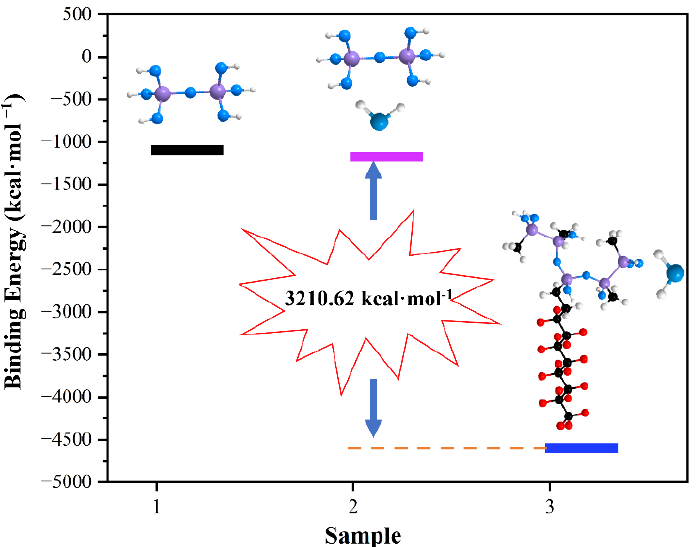
Figure 10. Diagram of adsorption energy (1 — SiO 2 ; 2 — SiO 2 molecular and H 2 O; 3 — FAS-17-modified SiO 2 molecular and H 2